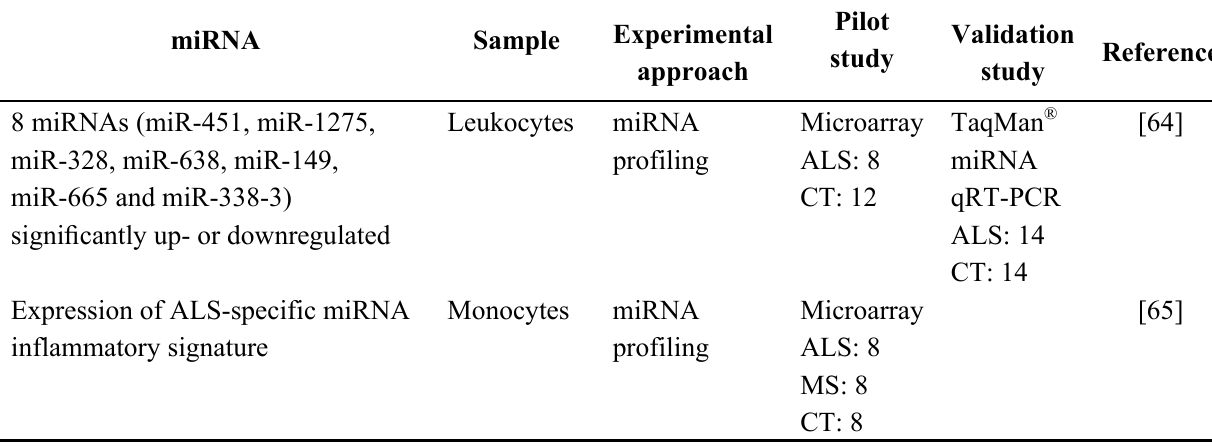
Table 3. Amyotrophic Lateral Sclerosis and circulating miRNAs. miRNA